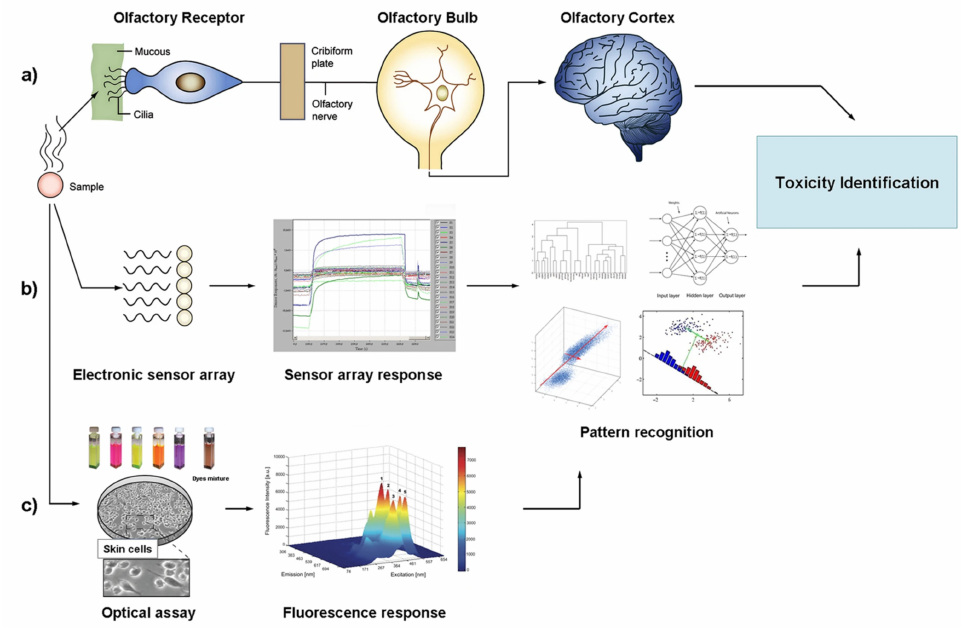
Figure 3. Fluorescence-based assay as a new screening tool for toxic chemicals in clinical trials, ( a ) human olfactory system, ( b ) electronic analogue, and ( c ) our optical analogue. Reprinted by permission from